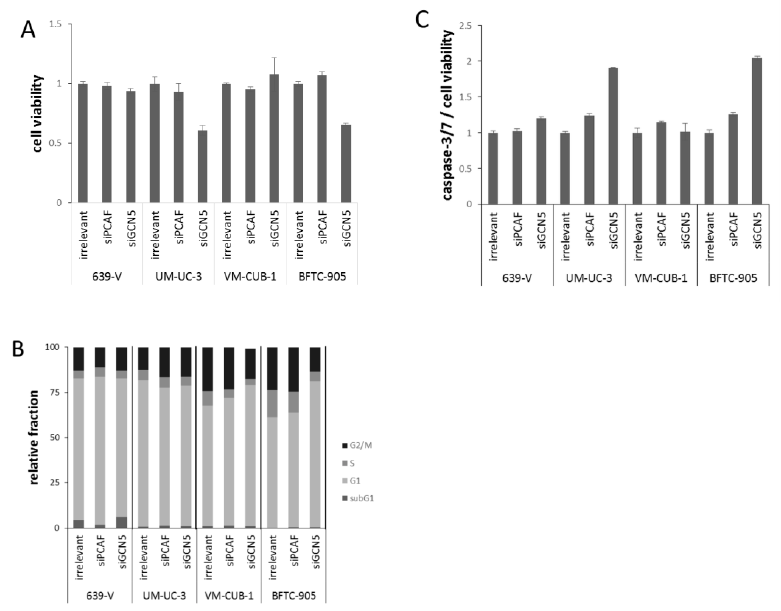
Figure 4. Cellular effects of single GNAT knockdown. ( A ) Cell viability 72 h after GCN5 or PCAF knockdown in UCCs as measured by CellTiter-Glo assay (measuring total ATP). For each cell line, values were set as 1 for the treatment with irrelevant siRNA; ( B ) Cell cycle distribution after GCN5 or PCAF knockdown in UCCs as measured by flow cytometry (mean of triplicate values). The amount of apoptotic cells is reflected as subG1 fraction. Note an increased G2/M fraction in UM-UC-3, a slight increase in the G1 fraction in VM-CUB-1 and a more profound G1 arrest in BFTC-905 cells treated with siGCN5; ( C ) Caspase 3/7 activity after GCN5 or PCAF knockdown in UCCs. Values obtained by the Caspase-Glo assay were normalized to viability of each condition. For each cell line, values were set as 1 for the treatment with irrelevant siRNA.